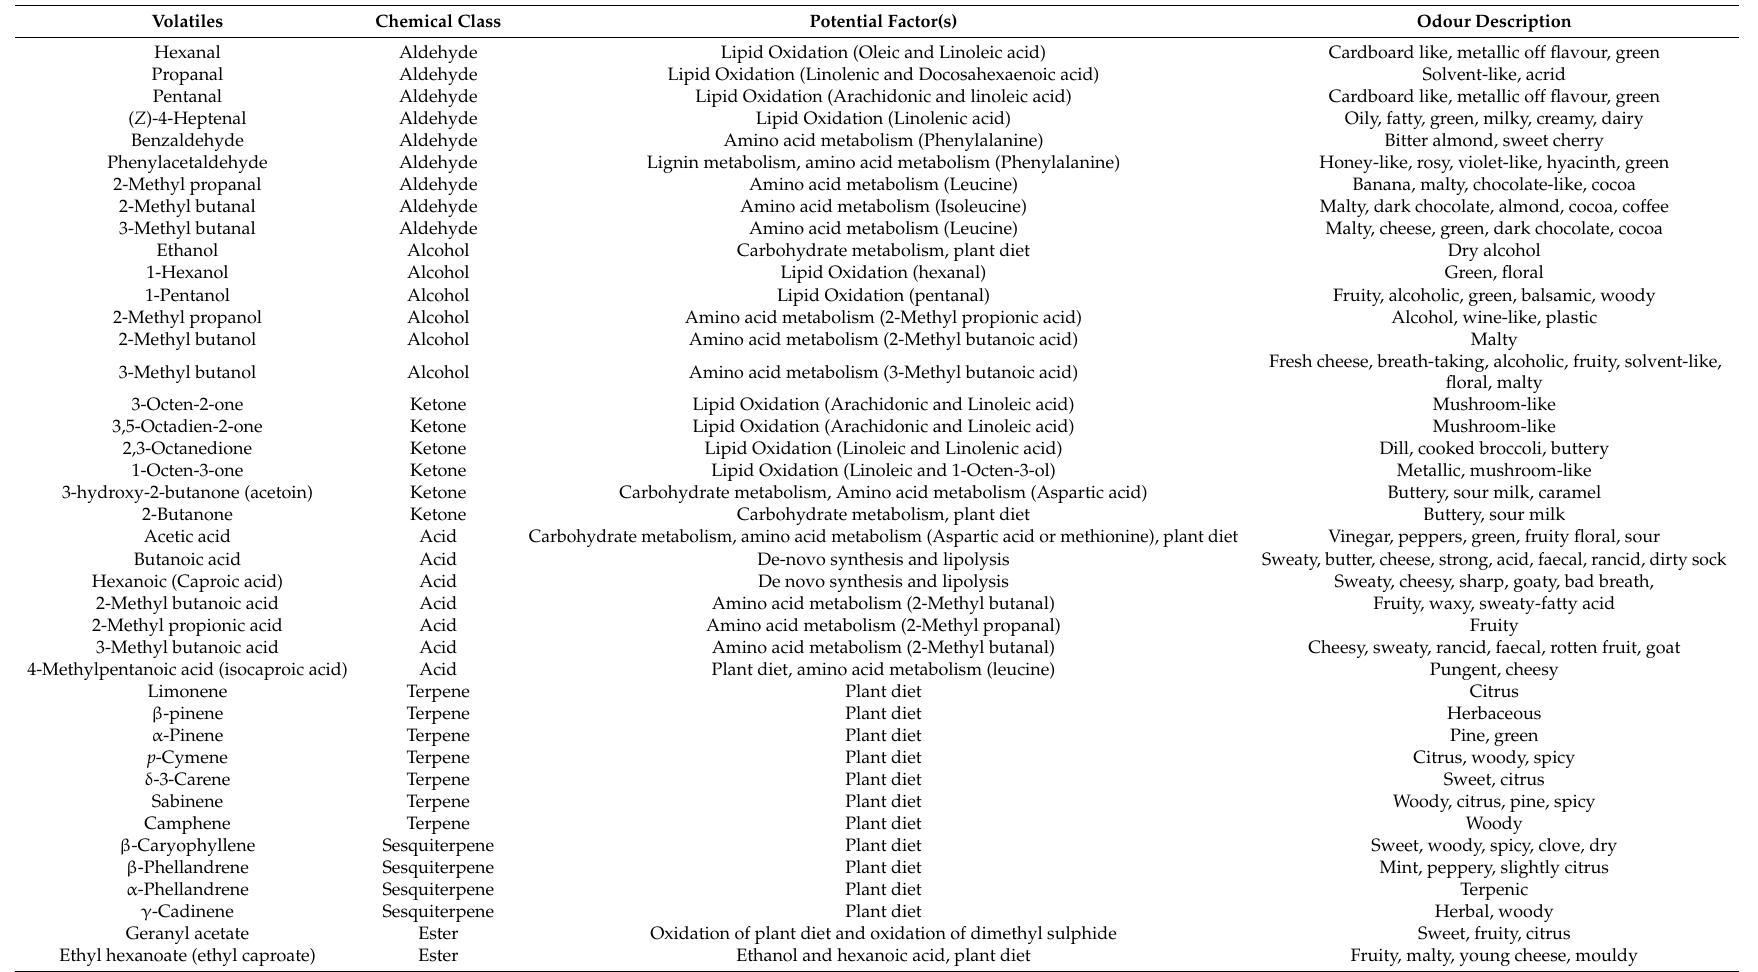
Table 1. Potentially important volatiles derived from diet in bovine milk and